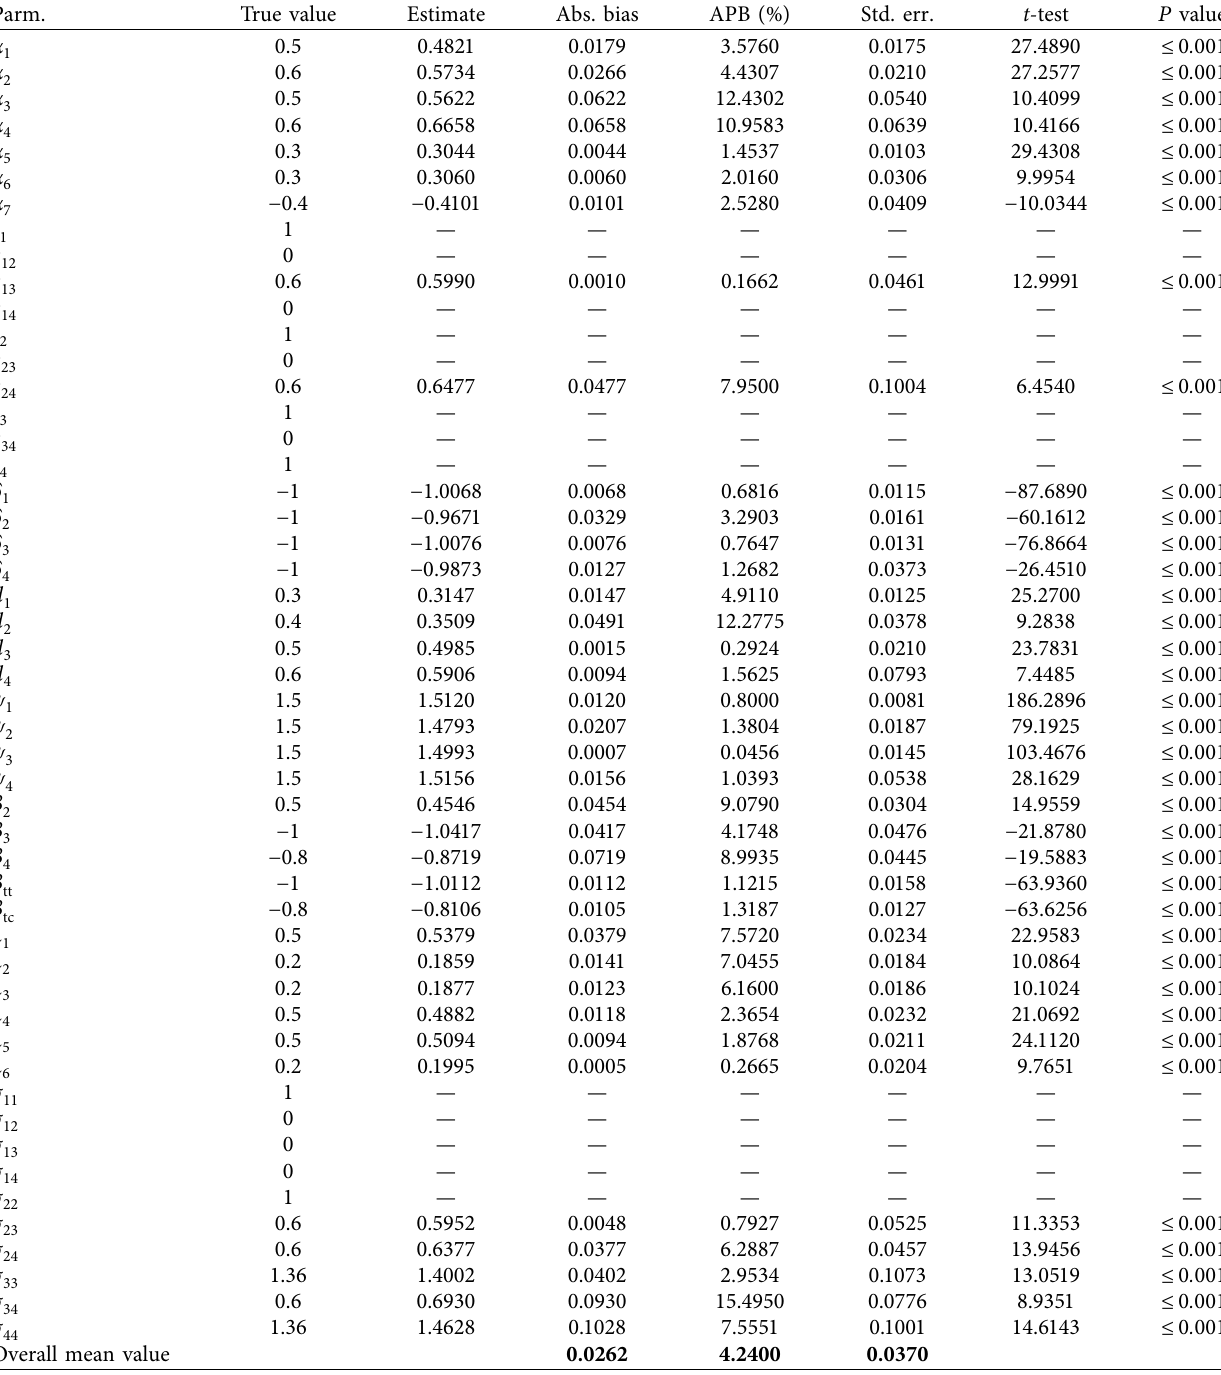
Table 5: Simulation results for the four-alternative ICLV model with the BME method.